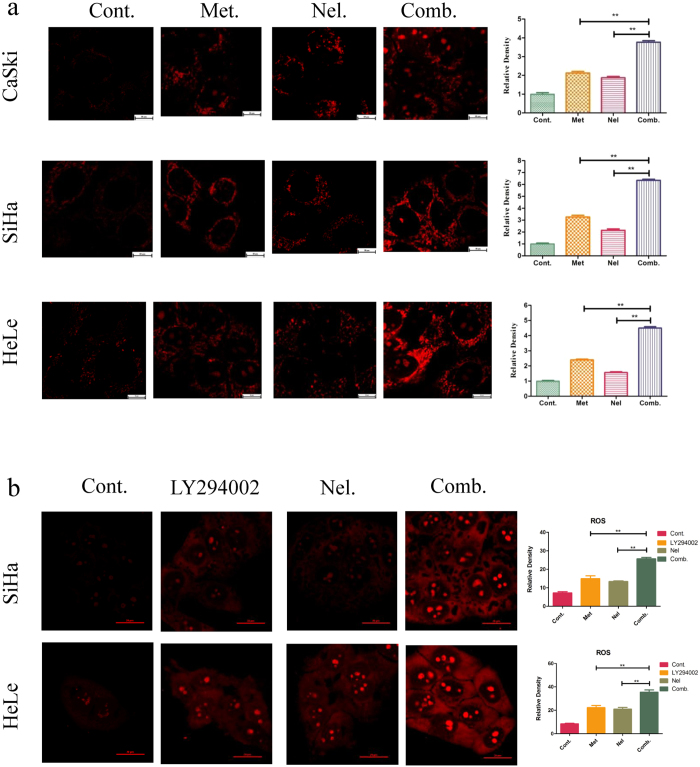
Inducing ROS production in SiHa, HeLa and CaSki cells by metformin (a) or LY294002 (b) and nelfinavir, alone or in combination a. SiHa, HeLa and CaSki cells were treated with 10 mM metformin or 4 μM nelfinavir, alone or in combination, for the indicated times. MitoSOX™ Red mitochondrial superoxide indicator. Each sample was tested in triplicate and data are shown as means ± SEM. Values are expressed as the fold change of untreated control at the indicated time point. The test for synergy: *p < 0.05; **p < 0.01, compared to untreated control or individual drug (Cont, control; Met, metformin; Nel, Nelfinavir; Comb, the combination of metformin and nelfinavir).